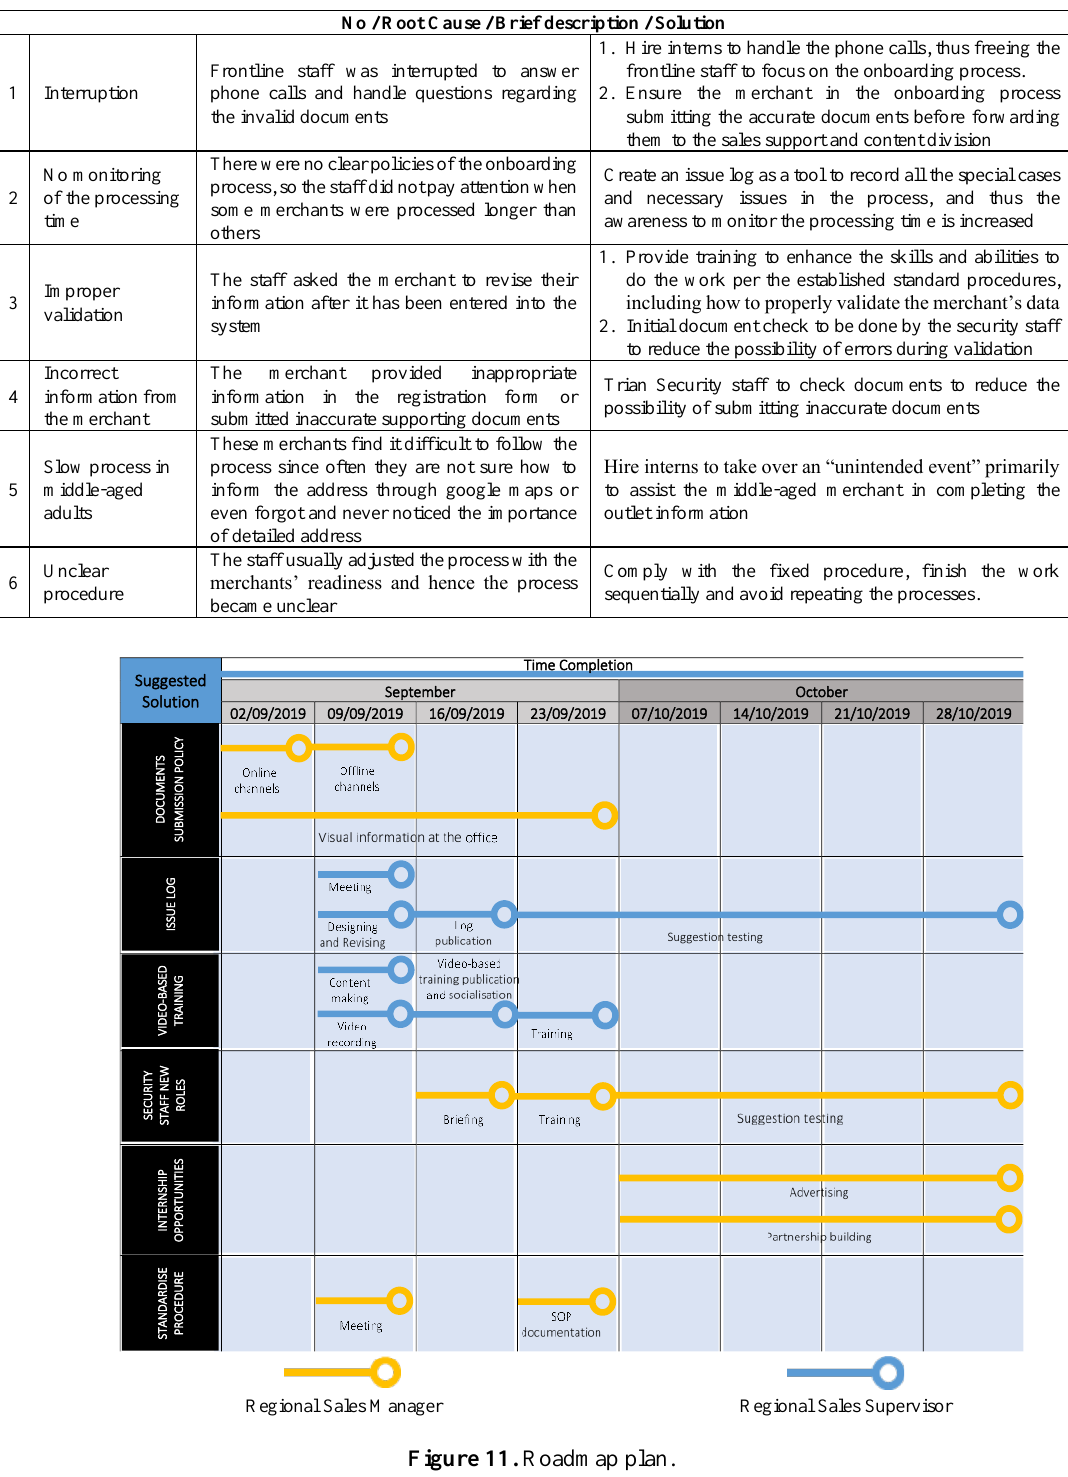
Table 4. Identified solutions for root causes.